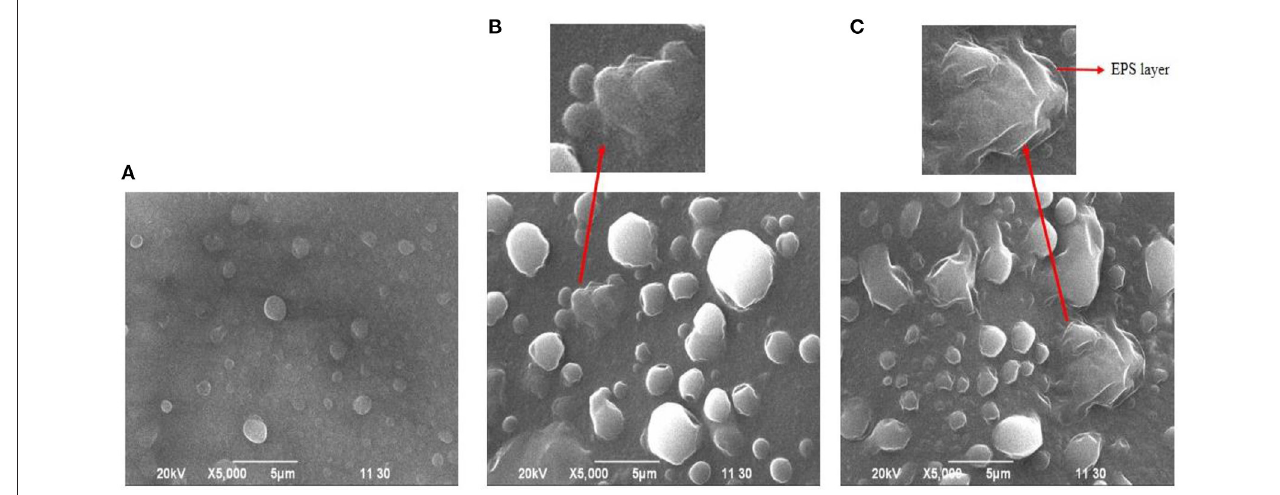
FIGURE 5 | Biofilm formation by S. pavanii BRF2 at 0 (A) , 100 (B) , and 200mM (C) NaCl concentrations under a scanning electron